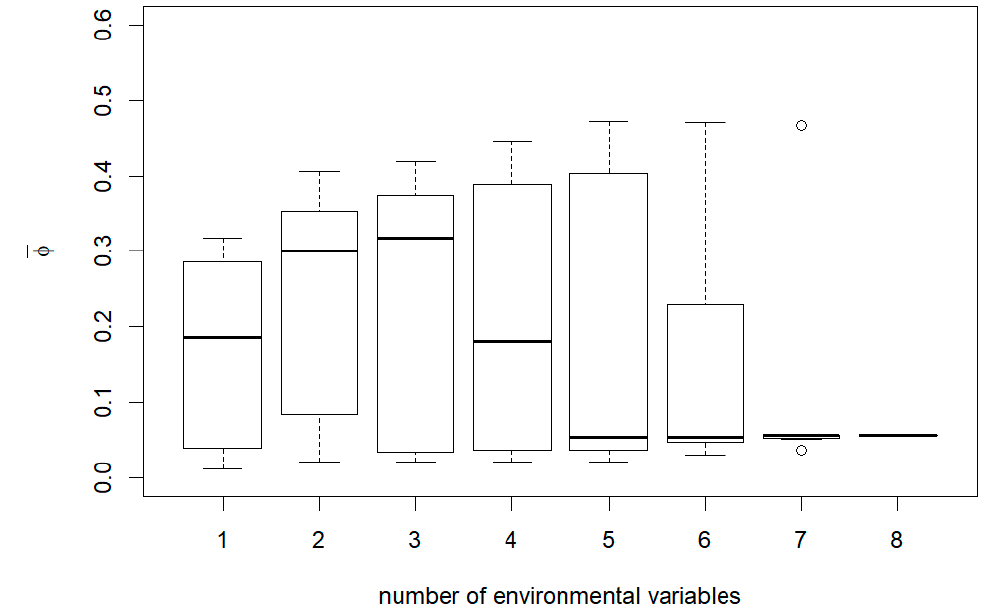
Figure A9. Box plot of mean phi coefficients ( φ ) of the FDMs generated by KNC as affected by the number of explanatory variables. Box plot shows median plus upper and lower quartiles for φ of FDMs with a given number of explanatory variables. Minimum and maximum values are indicated by the upper and lower whiskers (1.5 × interquartile range). Circles are outliers.